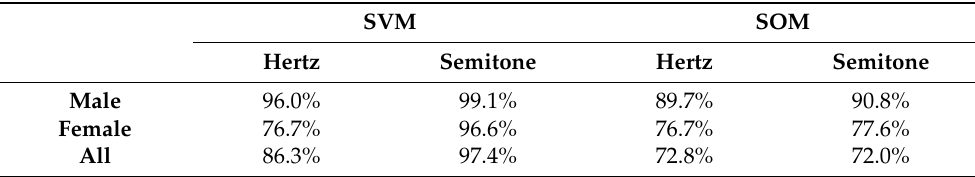
Table 1. Tone recognition rates using raw f 0 contours based on SVM and SOM